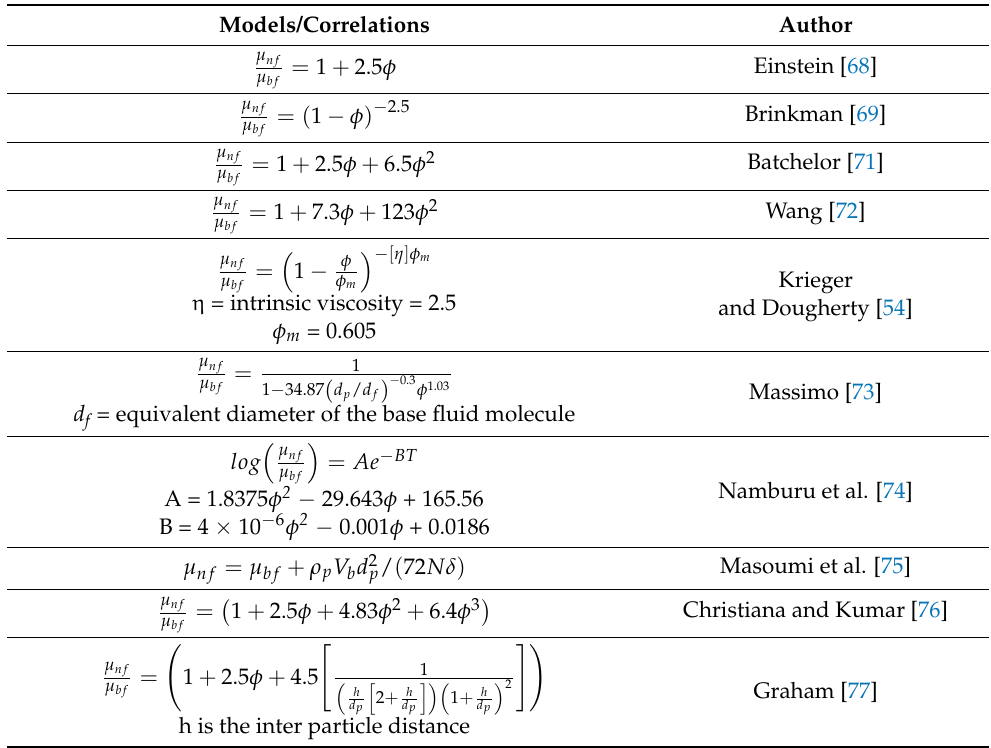
Table 4. Viscosity estimation of metal oxide based nanofluids (Model and correlations).